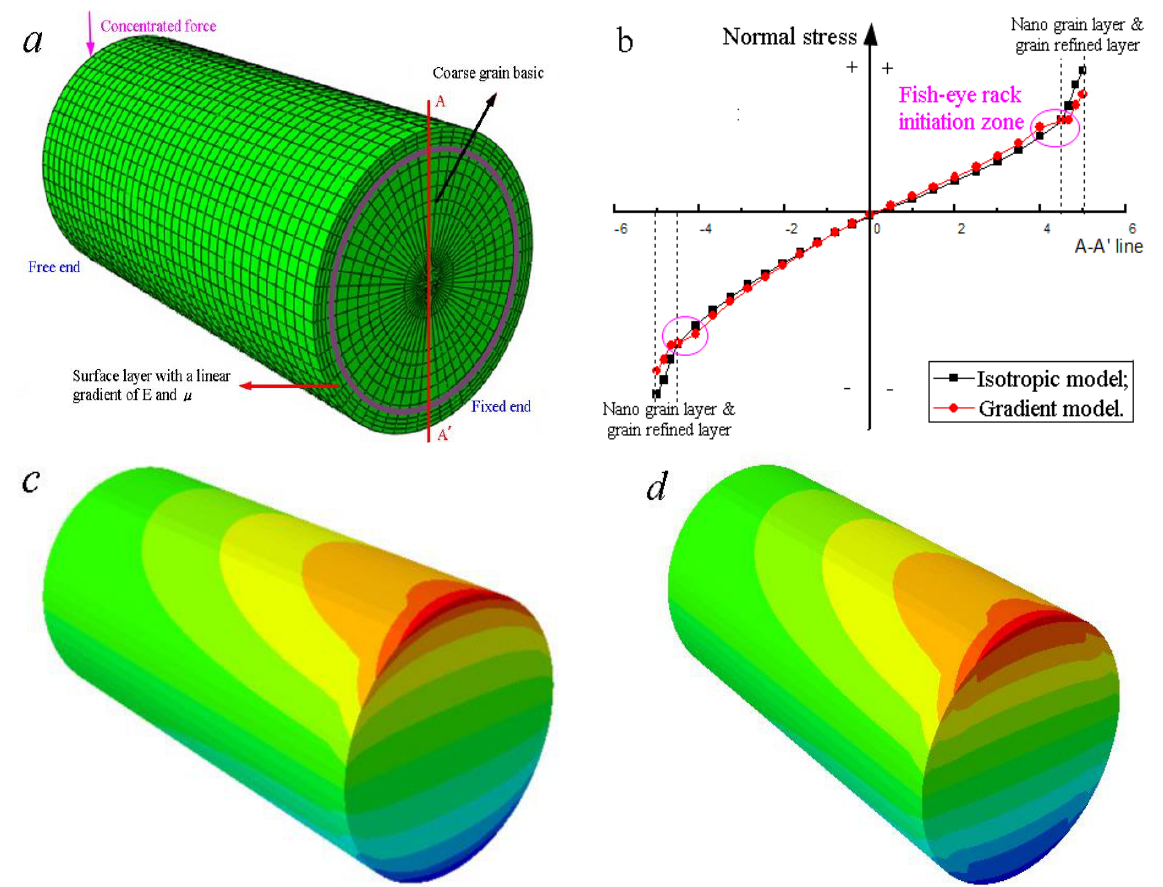
Figure 10. Simulation analysis of bending normal stress: ( a ) stratification model of a cantilever beam; ( b ) maximum normal stress is reduced with surface nanograins; ( c ) distribution of normal stress of isotropic model (E and μ of surface are a little lower than that of the basic); ( d ) distribution of normal stress of gradient model (both E and μ of surface are with gradient changes).